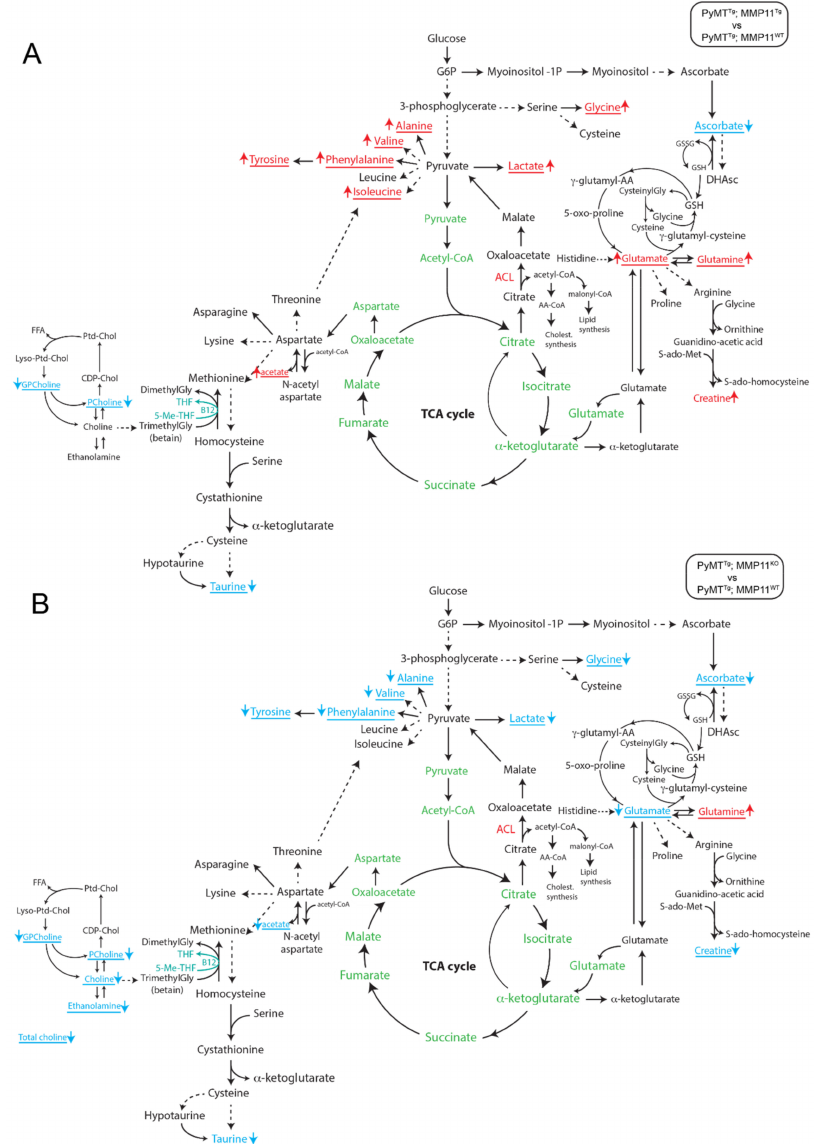
Figure 6. Results of the algorithm to determine the expected metabolite level alterations (ADEMA) network analysis of NMR high resonance magic angle spinning (HRMAS) metabolomics profile of mammary gland tumors in mice: ( A ) between PyMT Tg ; MMP11 Tg mice compared to PyMT Tg ; MMP11 WT controls and ( B ) between PyMT Tg ; MMP11 KO compared to PyMT Tg ; MMP11 WT controls. The metabolites underlined and written with an arrow for each one indicate the metabolites that are predicted to increase and decrease in PyMT Tg ; MMP11 Tg ( A ) or PyMT Tg ; MMP11 KO ( B ). The metabolites in green are present in the mitochondria. GSH: reduced glutathione; GSSG: oxidized glutathione; DHAsc: dehydroascorbate; g-glutamyl-AA: g-glutamyl-amino acid; Gly: glycine; ACL: ATP citrate lyase; AA-CoA: